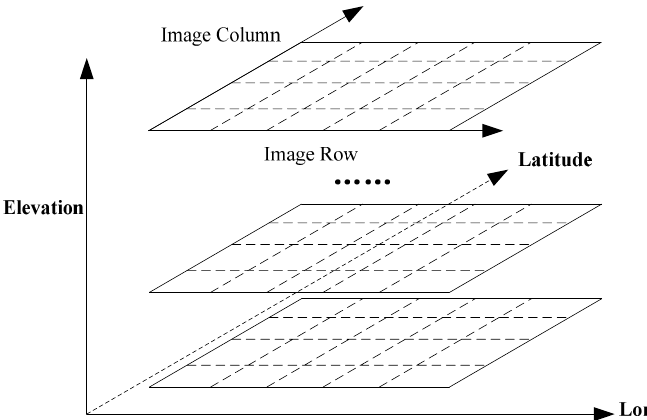
Figure 3. This shows the structure of the controlling grid. Note that the image columns and rows are not necessarily parallel to meridians or the equator and the layers are not necessarily divided into 5 × 4 chessboards as showed.